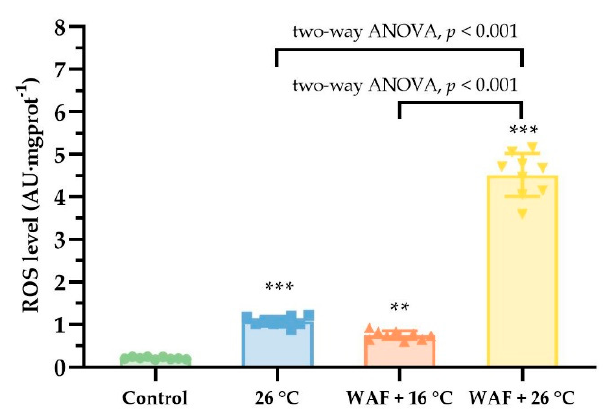
Figure 3. Reactive oxygen species (ROS) levels in the body wall of sea cucumber following exposure to elevated temperature (26 ◦ C, light-blue filled square), water-accommodated fractions (WAF) of Oman crude oil at an optimal temperature of 16 ◦ C (WAF + 16 ◦ C, light-red filled up-triangle), and Oman crude oil WAF at an elevated temperature of 26 ◦ C (WAF + 26 ◦ C, light-yellow filled down-triangle). The Control was the sea cucumber exposed to pre-filtered natural seawater only at an optimal temperature of 16 ◦ C (light-green filled circle). Error bars represent 95% confidence intervals. Asterisks (**, or ***) denote the significant differences between the treatments and the Control ( p < 0.01, or 0.001, respectively). Dark traits denote the significant differences among the treatments (two-way analysis of variance (ANOVA)).